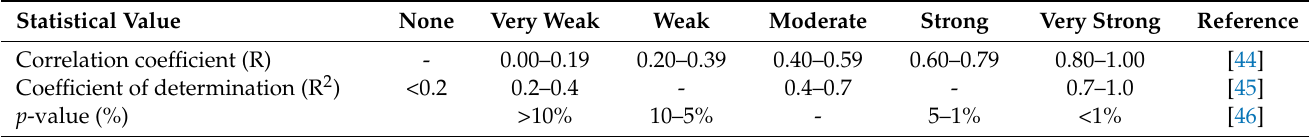
Table 2. Model performance scale for LRA validation.